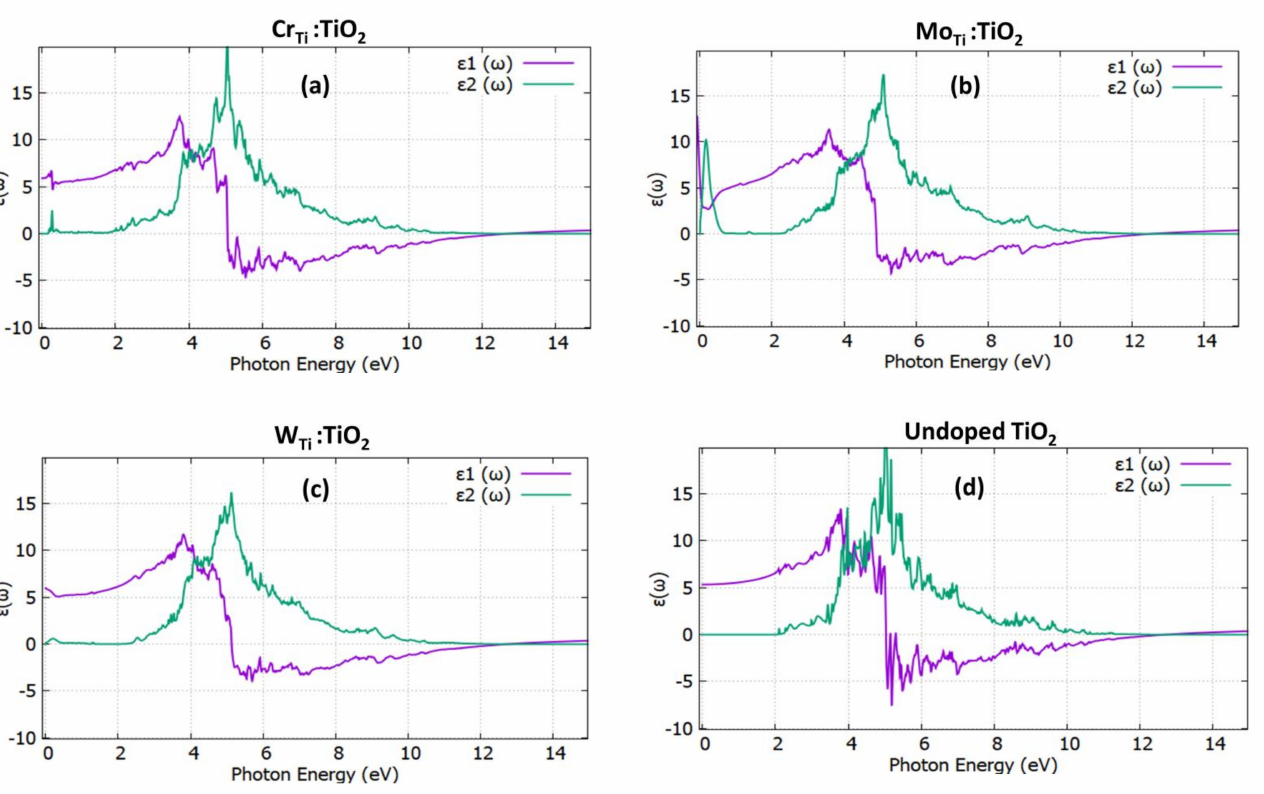
Figure 4. The real ε 1 ( ω ) and imaginary part ε 2 ( ω ) of the complex dielectric function for ( a ) Cr doped TiO 2 , ( b ) Mo doped TiO 2 , ( c ) W doped TiO 2 , ( d ) undoped TiO 2 .